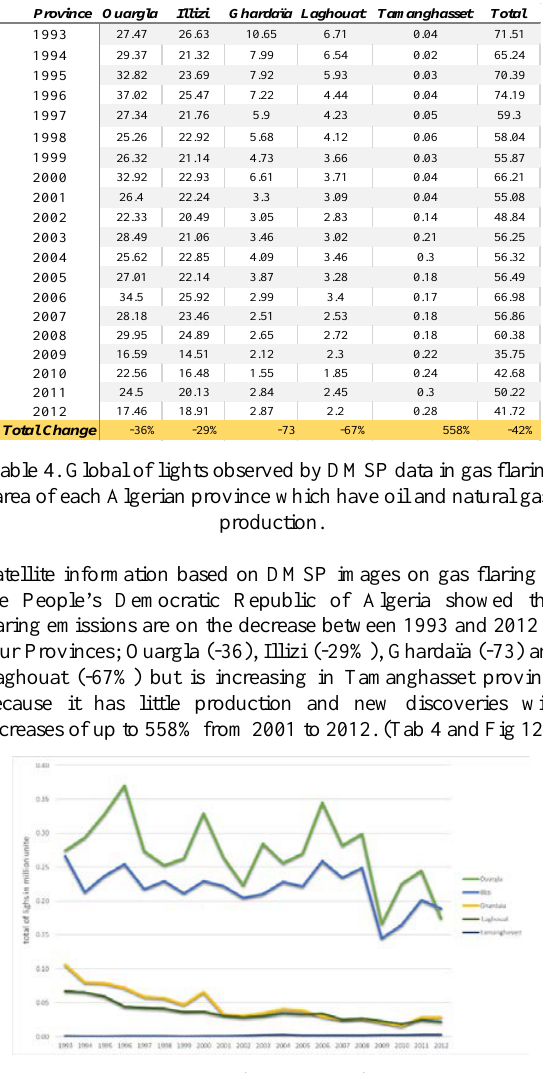
Figure 12. Global of lights (million unite) observed by DMSP data in gas flaring